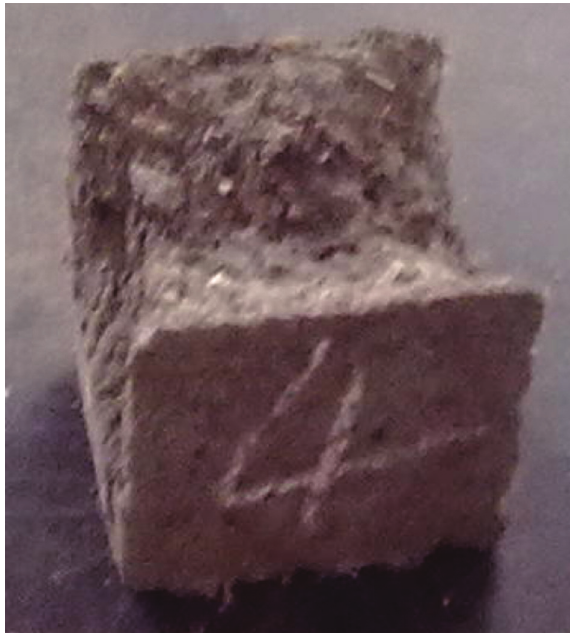
Figure 8 Thermal conductivity of hardened mortar panels as a function of feather fiber content.